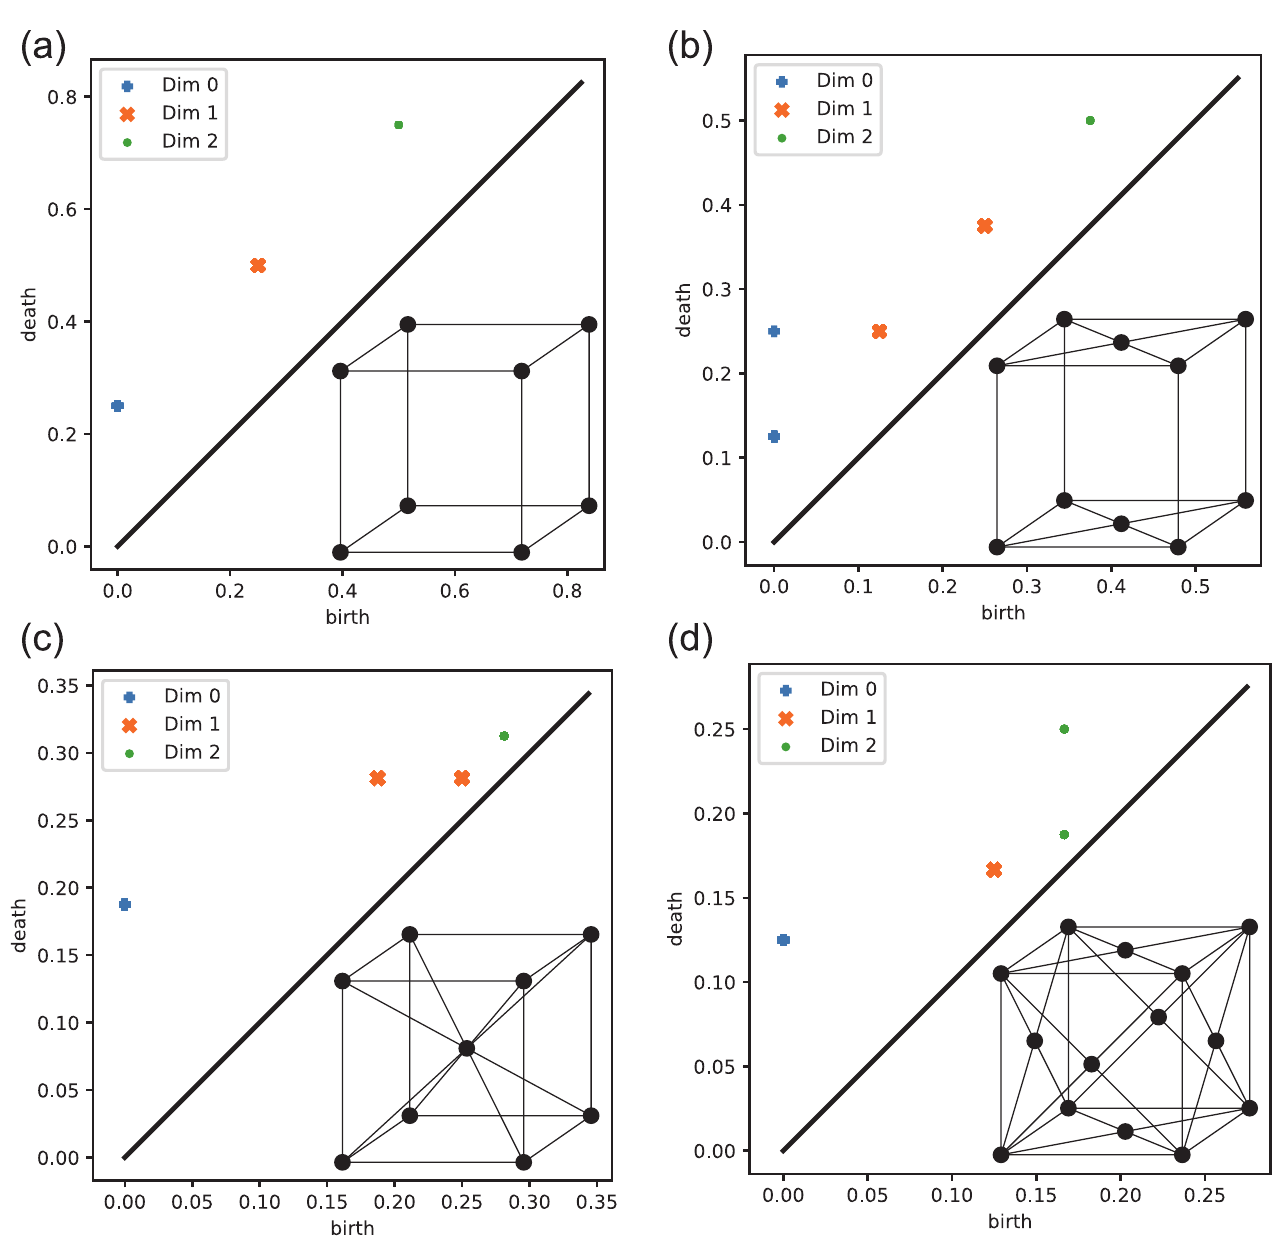
Fig 4. Persistent diagrams for the cubic lattices in Fig 2. In each panel, the blue pluses, orange crosses, and green dots indicate points for q = 0, 1, 2. In the right-bottom part of each panel, the corresponding lattice structures are shown. (a) type-P (Eq (2)). (b) type-C (Eq (3)). (c) type-I (Eq (4)). (d) type-F (Eq (5)).